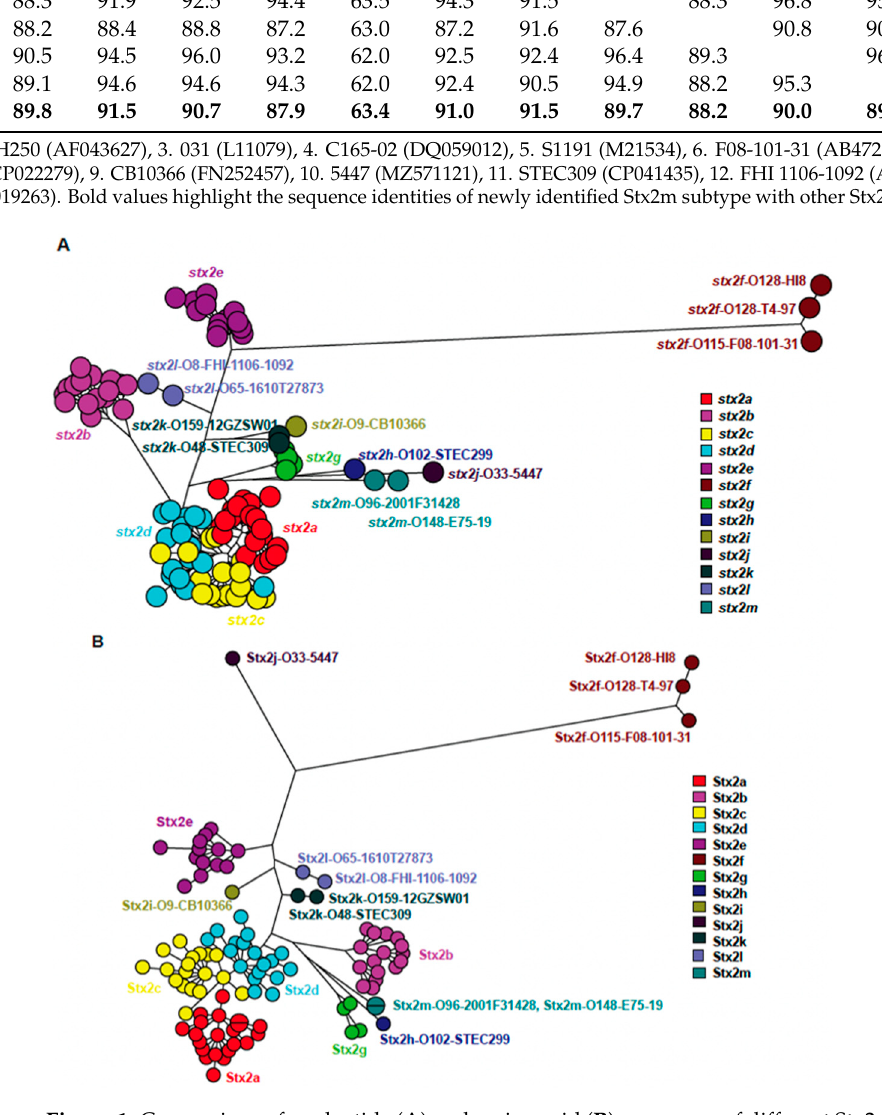
Figure 1. Comparison of nucleotide ( A ) and amino acid ( B ) sequences of different Stx2 subtypes using maximum parsimony cluster analysis. Stx2a, Stx2b, Stx2c, Stx2d, Stx2e, Stx2f, Stx2g adapted from Scheutz et al., 2012. Stx2h (Bai et al., 2018), Stx2i (FN252457), Stx2j (MZ571121), Stx2k (Yang et al., 2020) and Stx2l (EFSA BIOHAZ Panel,